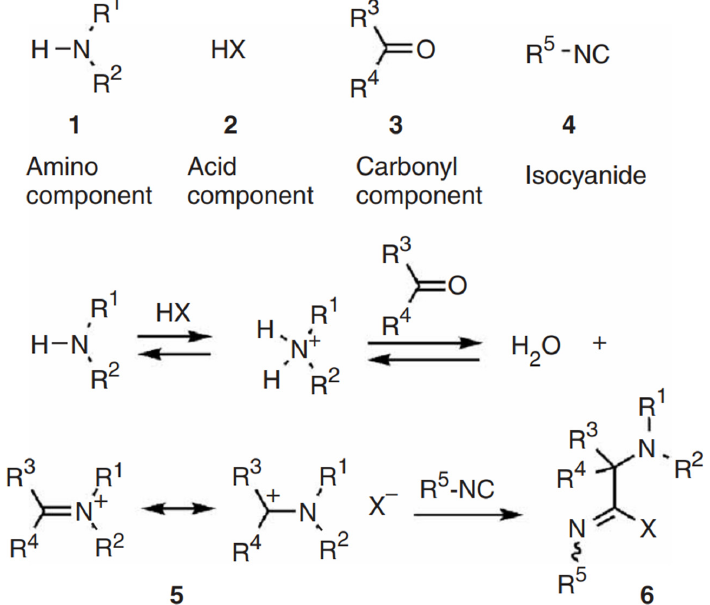
Figure 20. Synthesis of alternating polypeptoids and alternating polyamholytes via Ugi reaction of natural amino acids (Adapted from ref. [112]. Copyright 2018, American Chemical Society).